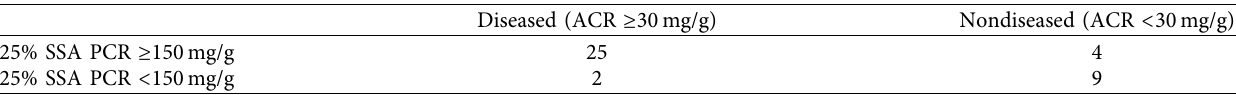
Table 5: Patient data for the calculation of performance characteristics of the 25% sulfosalicylic acid protein-to-creatinine ratio (SSA PCR) versus albumin-to-creatinine ratio (ACR).